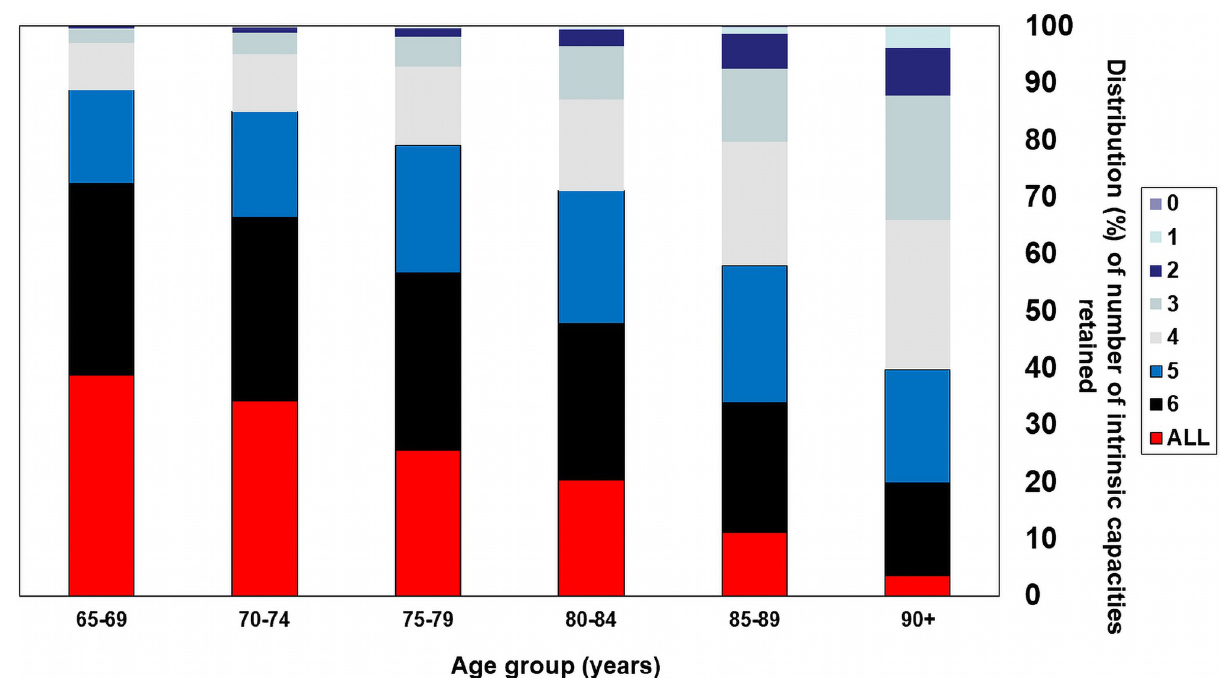
Fig 2. Distribution (percent) of number of intrinsic capacities retained, by age group.